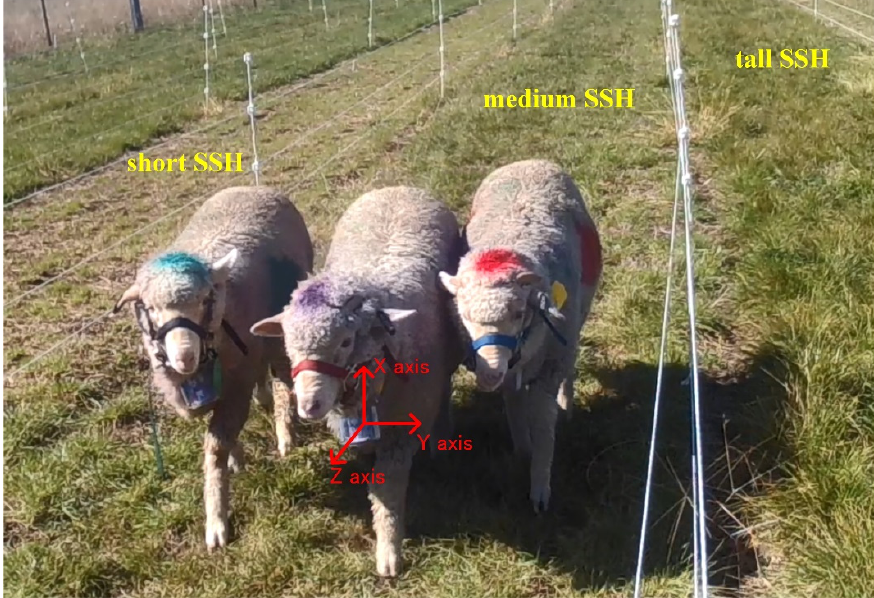
Figure 1. Experimental paddock on pastures with different sward surface heights (SSH). Location of inertial measurement unit (IMU) sensor and its orientation on sheep.